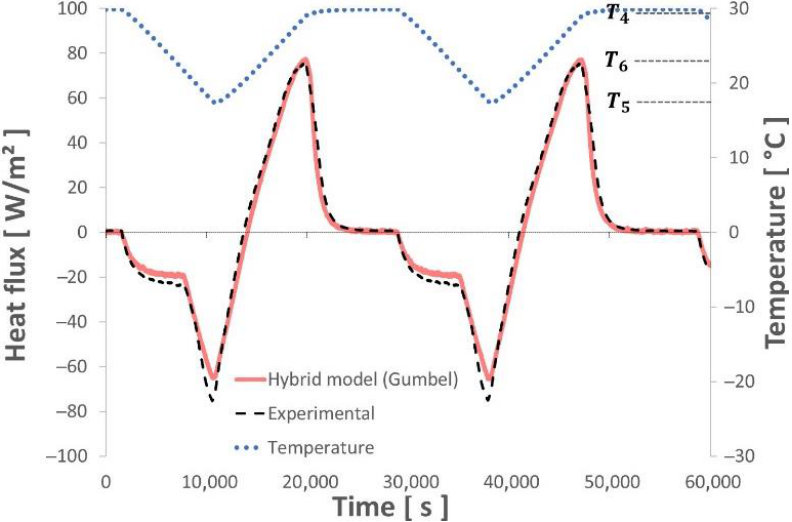
Figure 20. Evolution of the flux exchanged between the plate and the sample (partial solidification).